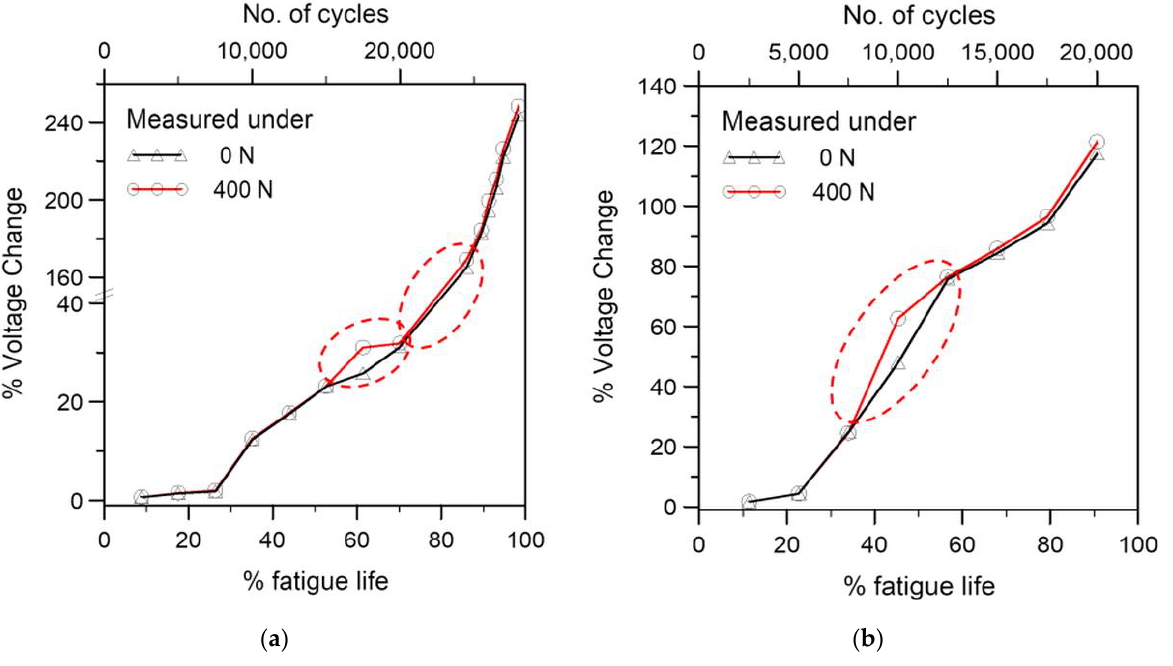
Figure 12. Comparison of percentage voltage change development measured at 0 N and 400 N in two fatigue specimens, note the difference at ( a ) 60% life; ( b ) 45% life.